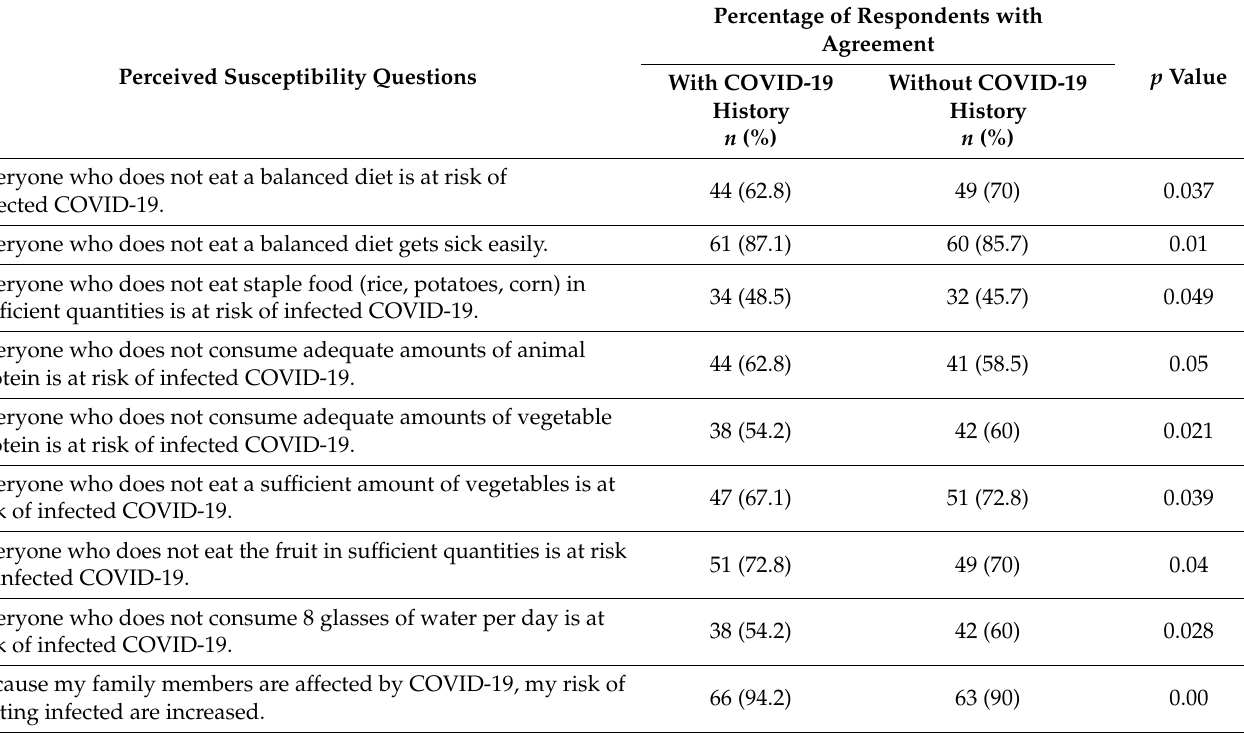
Table 2. Perceived susceptibility